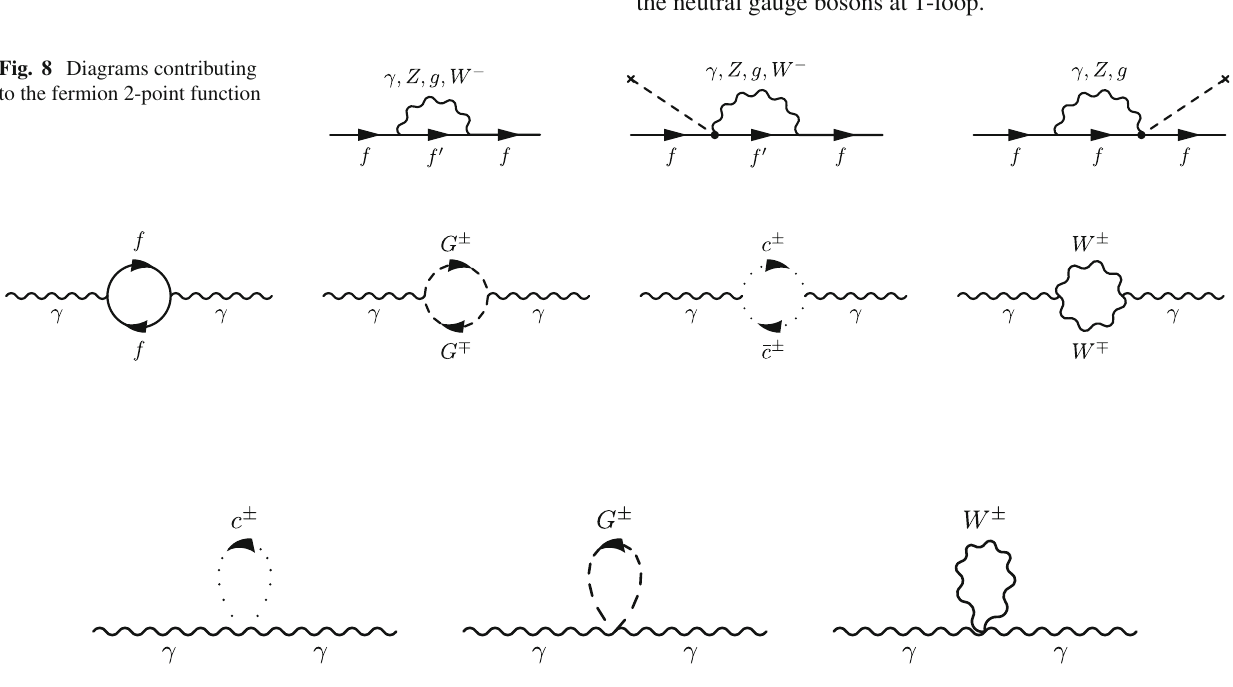
Fig. 9 Diagrams contributing to the photon 2-point